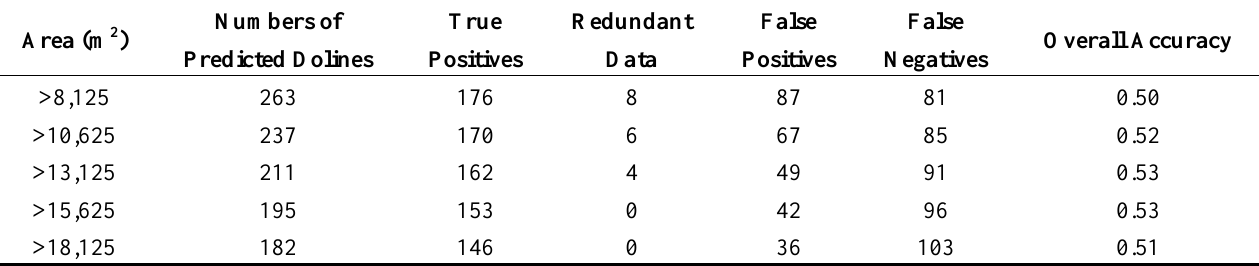
Table 6. Predicted dolines using area attribute from dolines depth > 2 m (ALOS/PRISM-DEM). The comparison is made with true dolines (249) obtained by visual